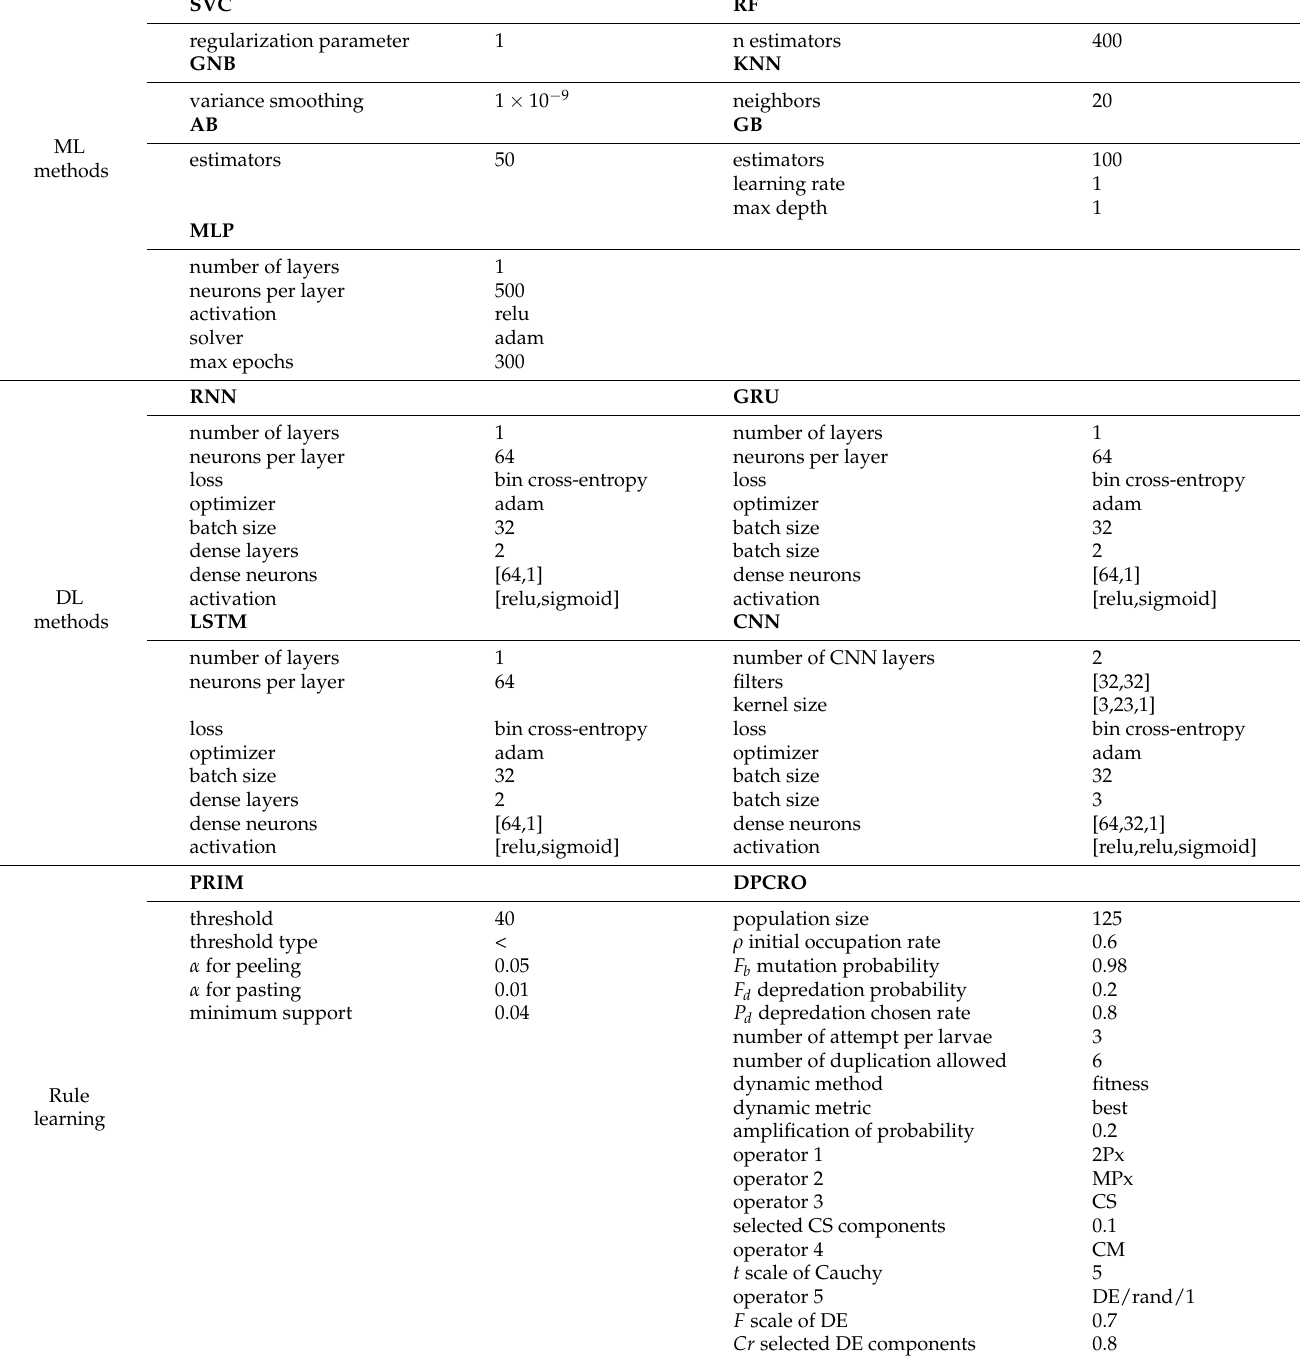
Table 2. Experimental